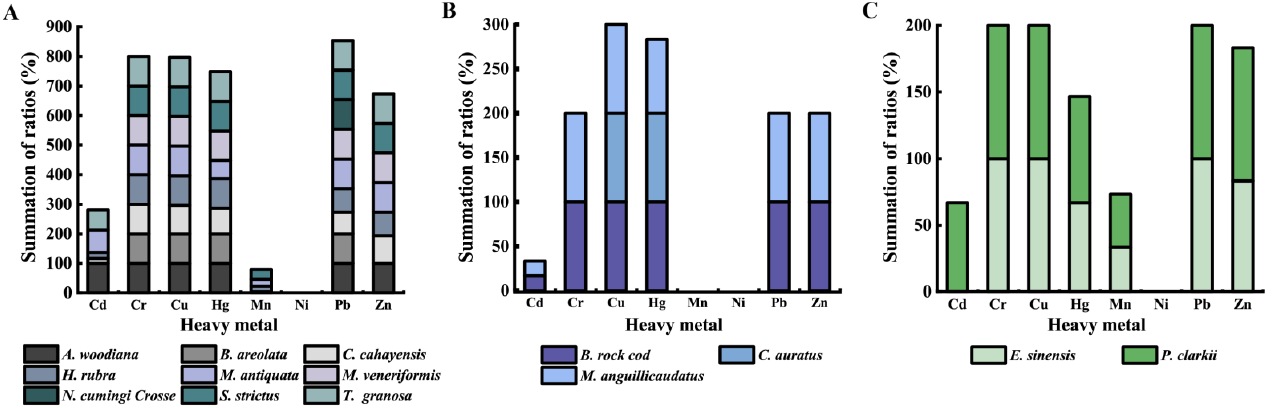
Figure 1. The heavy metal–tolerance profiles of the 94 K. pneumoniae strains in the 14 species of aquatic animals: mollusks ( A ), fish ( B ), and crustaceans ( C ). aquatic animals: mollusks ( A ), fish ( B ), and crustaceans ( C